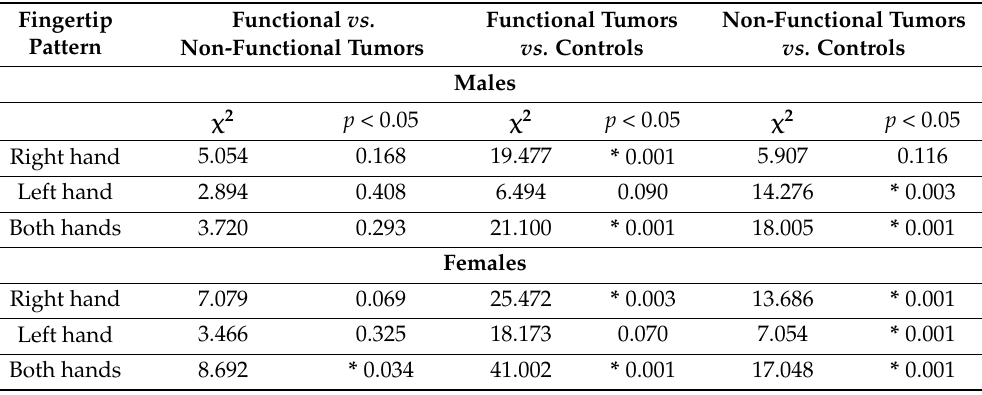
Table 4. Chi square test analysis of fingertip patterns (whorl, ulnar loop, radial loop, and arch) comparing groups with functional tumors, non-functional tumors and controls.